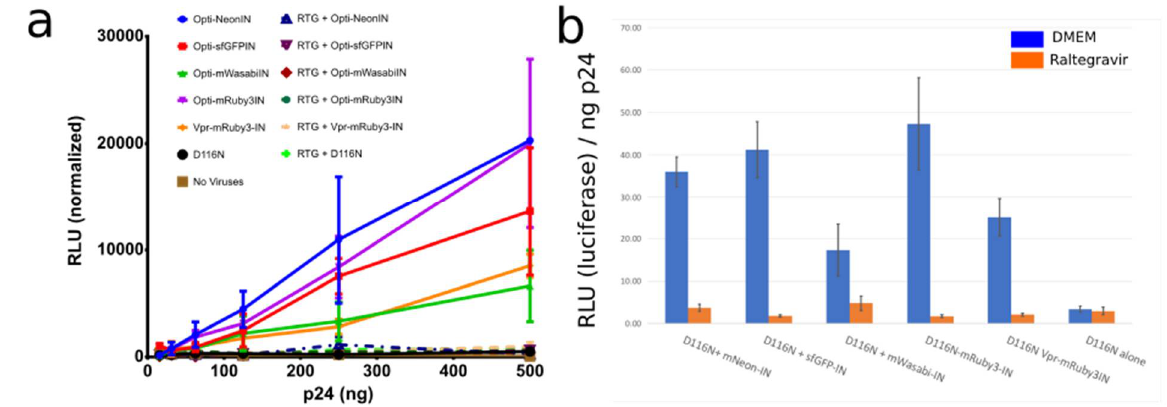
Figure 4. ( a , b ) Integration incompetent pNL4-3-D116N when produced with optiGag-Fluo supplemented in trans has integration restored to a higher level than Vpr-Ruby3-IN in HeLa cells. Raltegravir (RTG) was used as a control for IN inhibition of the labeled IN. Legend: Relative Light Units (RLU). Error Bars represent Standard Deviation of 3 independent experiments.